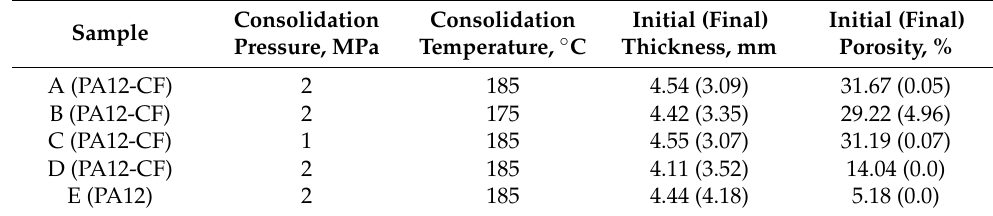
Table 3. Considered blockply samples and their consolidation setups.